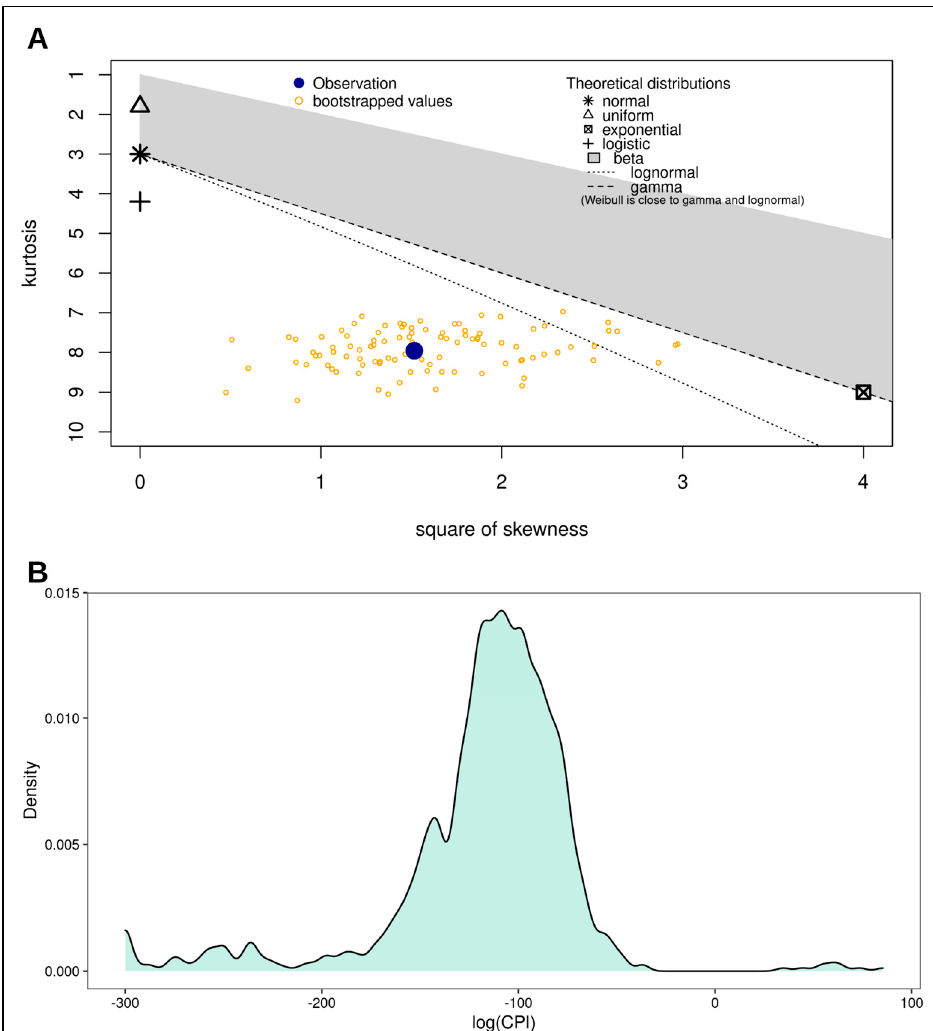
Figure 1. Distribution assessment for log(CPI). (A) Skewness-Kurtosis plot of log(CPI). This plot was produced as a further contribution for the assessment of normality for the log(CPI) distribution after the Shapiro-Wilk test. This plot shows the distribution of log(CPI) as determined by square of skewness and kurtosis. The blue dot represents statistics for the distribution, while the yellow dots represent the statistics for the bootstrapped distribution. Based on the position of the blue dot with respect to the position of the theoretical distributions, it is clear to see that both the blue dot and the yellow dots are far from the normal distribution. This indicates the distribution of log(CPI) is non-normal. (B) Density curve of log(CPI) highlighting the shape of the distribution. This plot was produced as a visual assessment of log(CPI) distribution, which is non-normal.